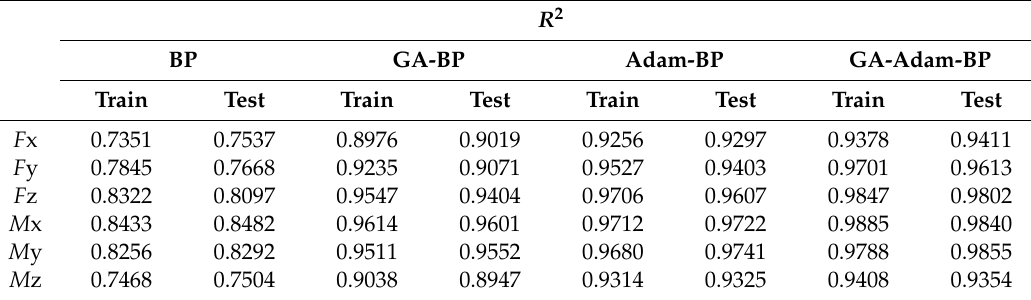
Table 2. The modeling results of four methods for six aerodynamic